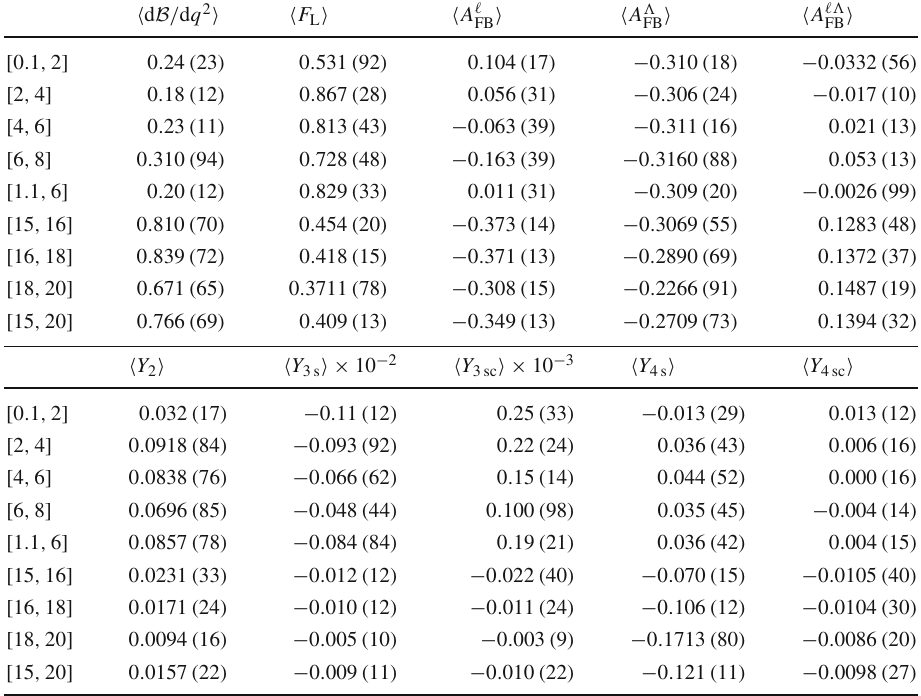
Table 3 SM predictions for the binned differential branching fraction (in units of 10 − 7 GeV − 2 ) and angular observables. The first column specifies the bin